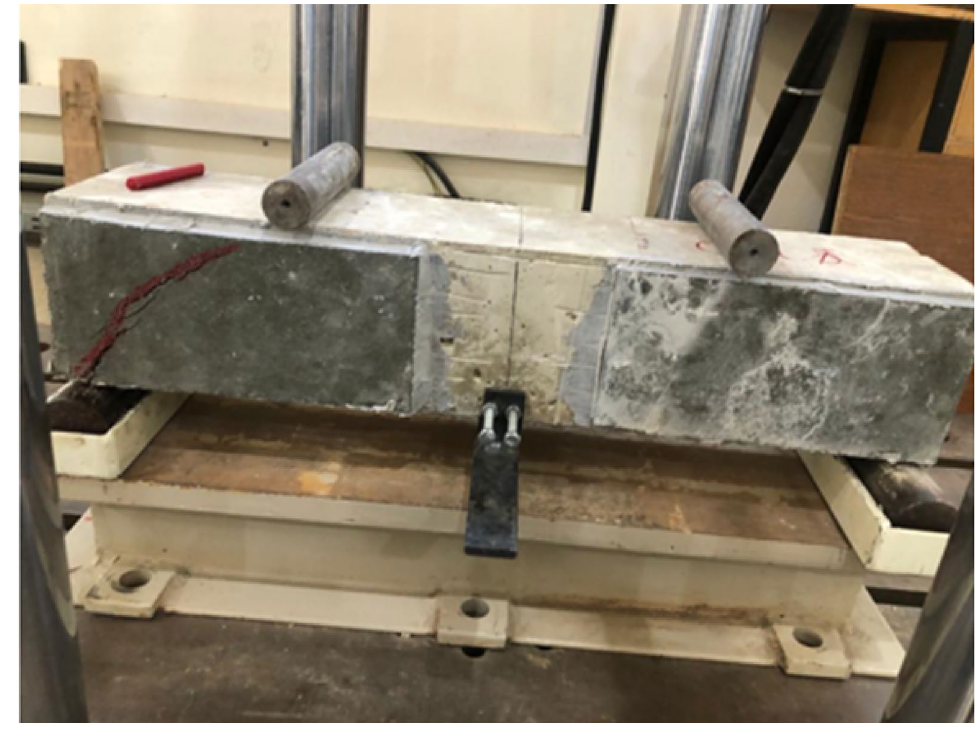
Fig. 13 RC beam without stirrups strengthened with HPFRC plates